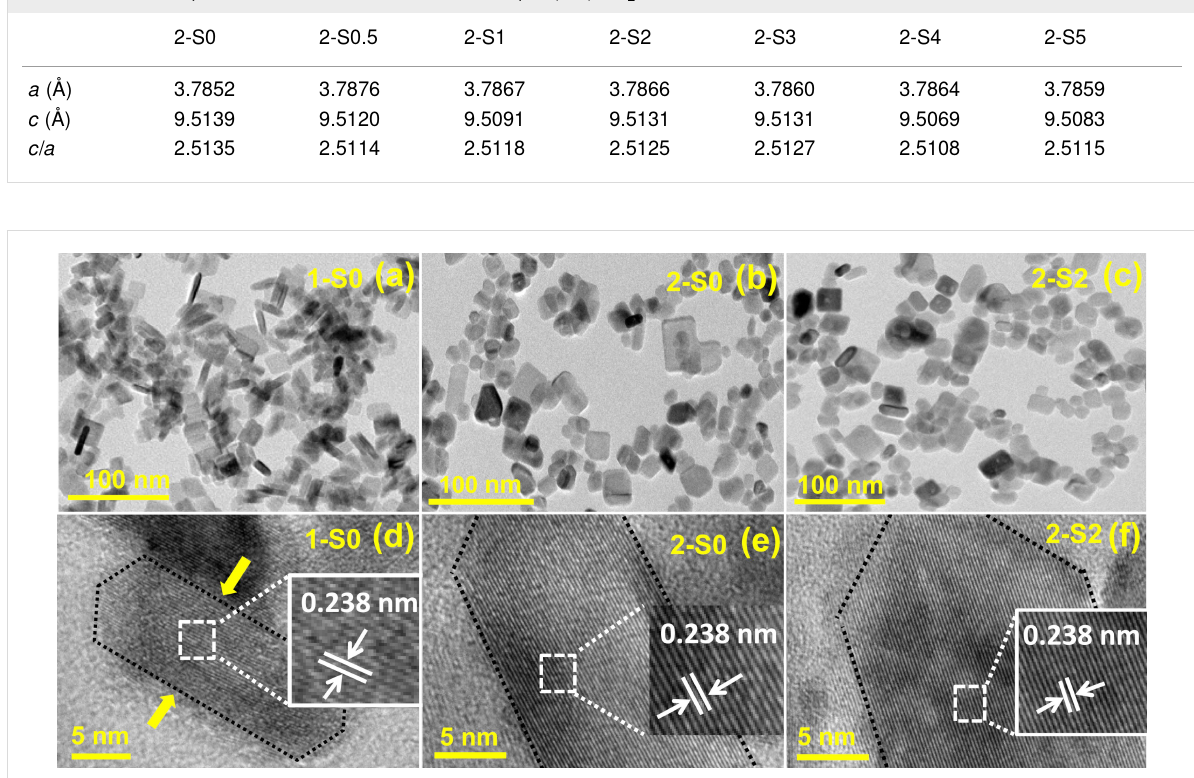
Figure 2: TEM images (a–c) and HRTEM images (d–f) for 1-S0, 2-S0, and 2-S2.